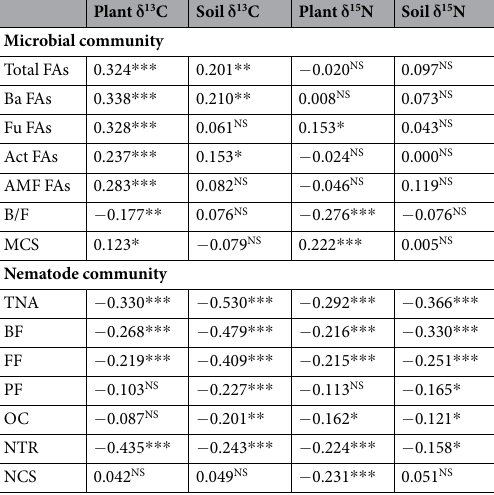
Plant δ 13 C Soil δ 13 C Plant δ 15 N